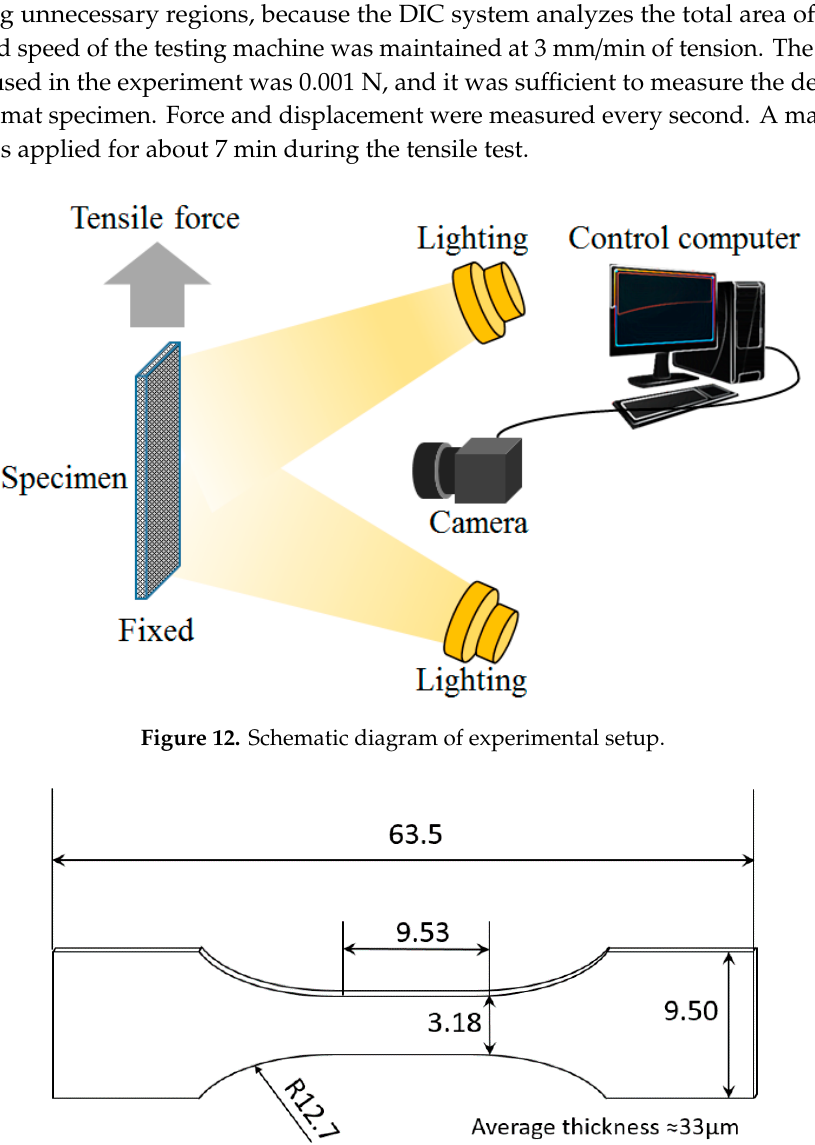
Figure 11. The photograph of a fabricated nanofiber mat.